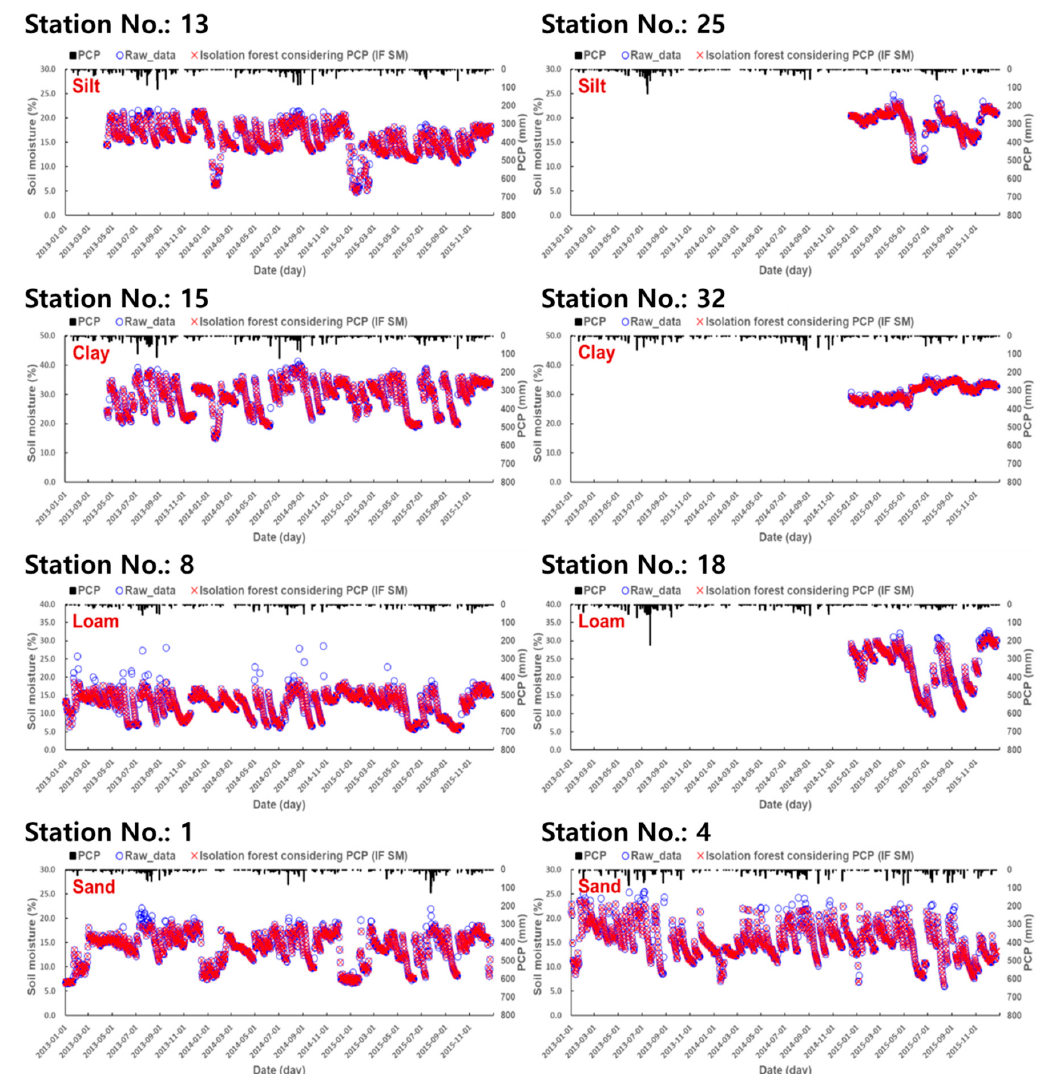
Figure 4. The graphs between original observed soil moisture (raw data) and observed soil moisture (SM) removed by isolation forest (IF) considering precipitation (PCP). Blue circles represent the original observed soil moisture before applying the IF method, and red Xs represent observed soil moisture after applying the IF method.